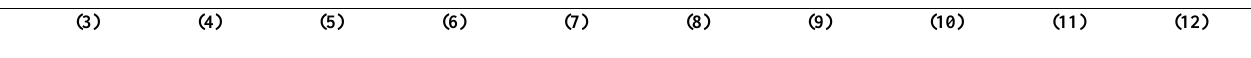
Table 2: Matrix of